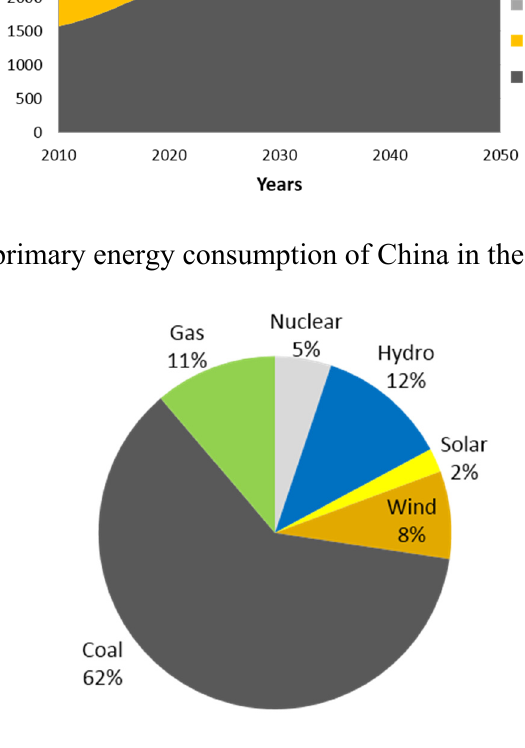
Figure 6. Shares of electricity power by 2050.